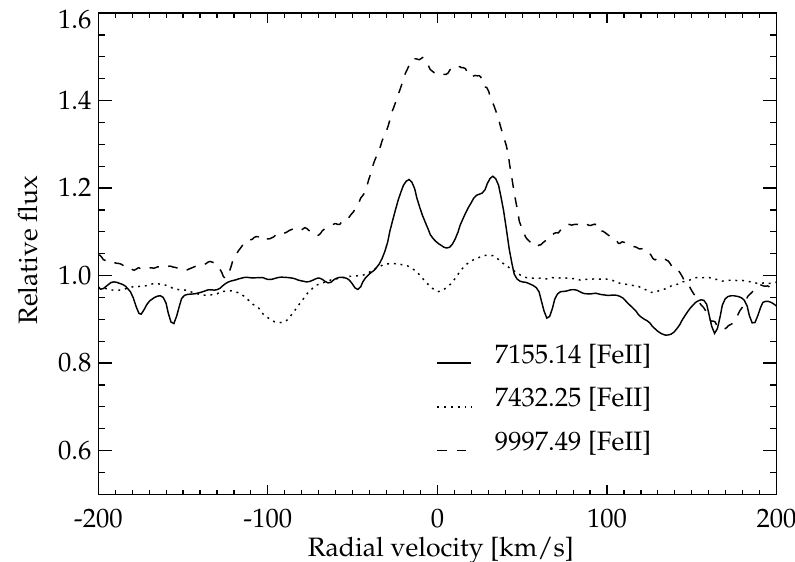
Fig. 4. Here some [Fe II] emission lines in the spectrum of υ Sgr are plotted in the velocity